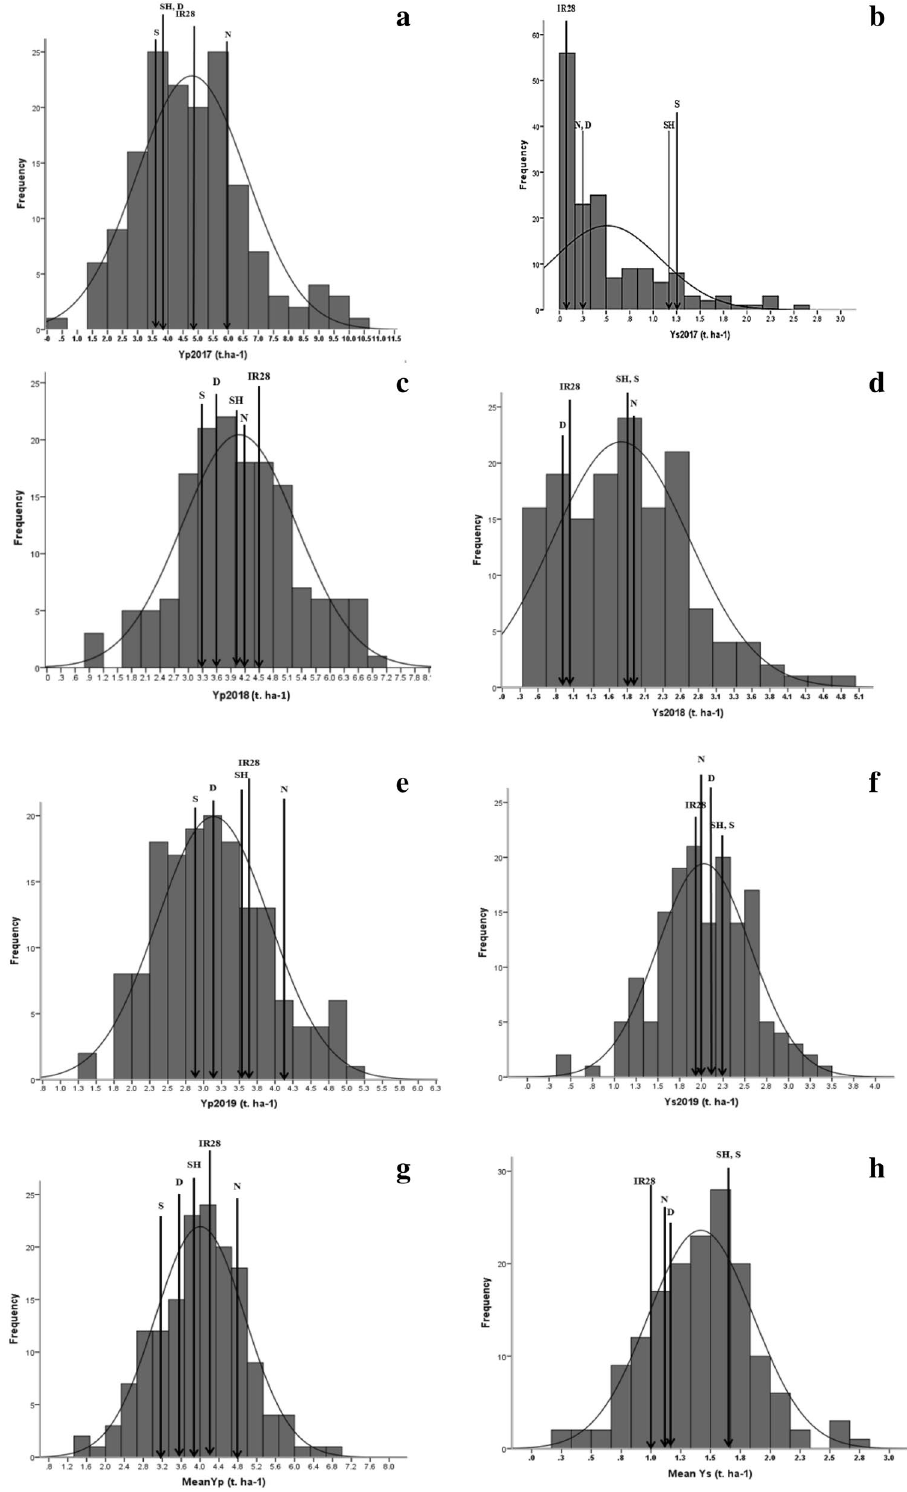
Figure 1. The histogram of frequency distribution of grain yield of 152 rice RILs, parental (IR28 and SH: Shahpasand) and check varieties (N; Neda, S; Sadri, D; Dorfak) under non-stress condition in 2017 ( a ), drought stress condition in 2017 ( b ), non-stress condition in 2018 ( c ), drought stress condition in 2018 ( d ), non-stress condition in 2019 ( e ), drought stress condition in 2019 ( f ), non-stress condition in average of all 3 years from 2017 to 2019 ( g ) and drought stress condition in average of all 3 years from 2017 to 2019 ( h